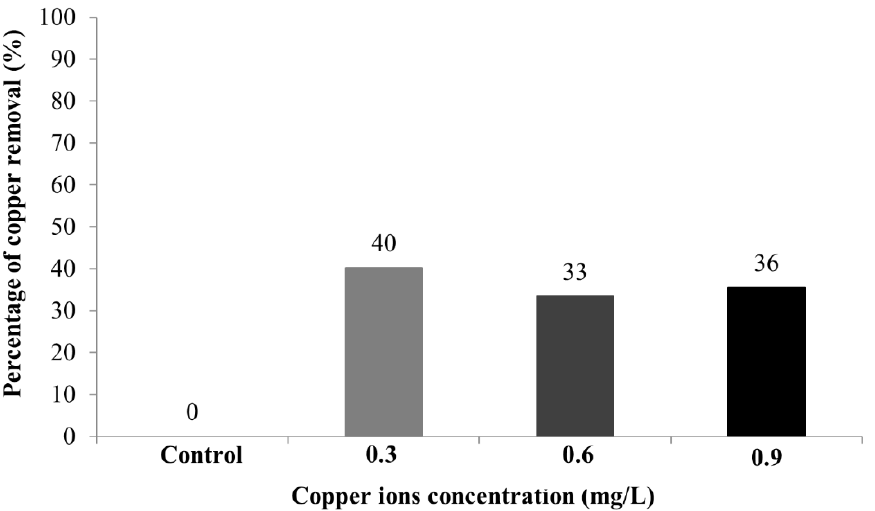
Figure 2. Copper removal capacity by C. protothecoides .